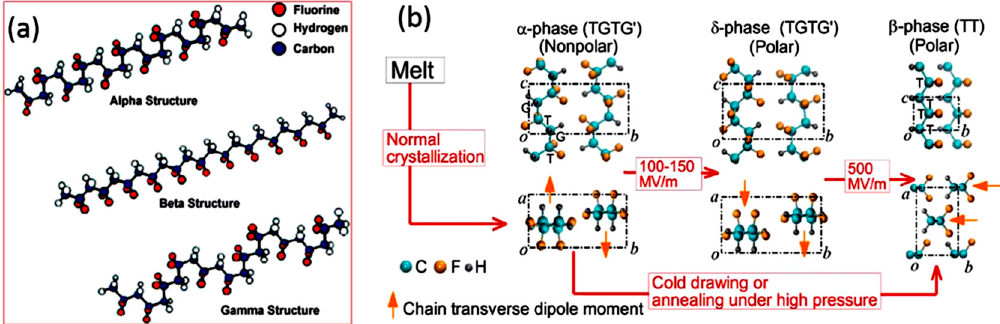
Figure 3. ( a ) Primary polymorphs of PVDF ( α , β , γ ). ( b ) Electric field-induced phase transitions of PVDF. The transverse dipole moment of each polymer chain is shown using an orange arrow that points from the negatively charged fluorine atoms to the positively charged hydrogen atoms. T-trans; G-gauche [28].